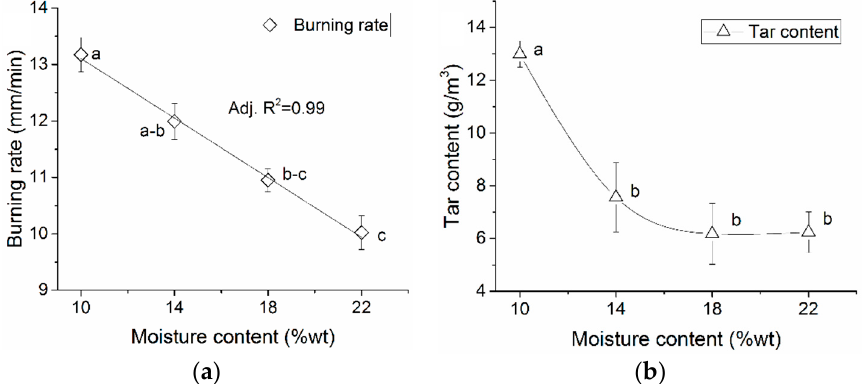
Figure 5. ( a ) Burning rate and ( b ) tar content in syngas using biomass with varying moisture contents (airflow rate 20 lpm, avg. particle size 7 mm, biomass compactness 0 kg). Different letters on data points indicate significant differences ( p < 0.05).